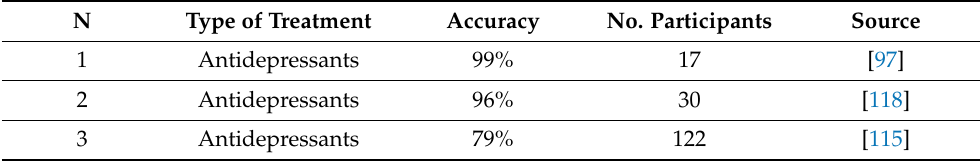
Table 4. EEG predictive accuracy of treatment for depressive disorder.